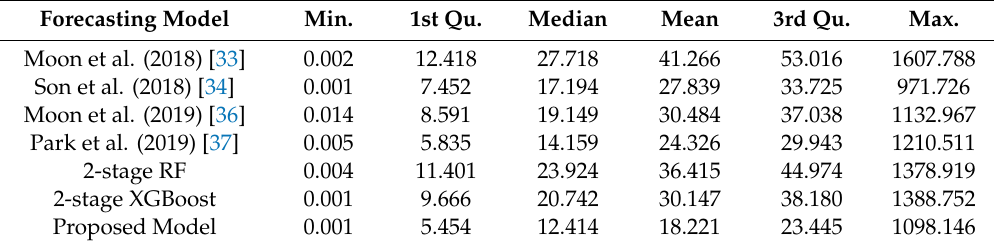
Table 11. Statistical analysis of APEs by each forecasting